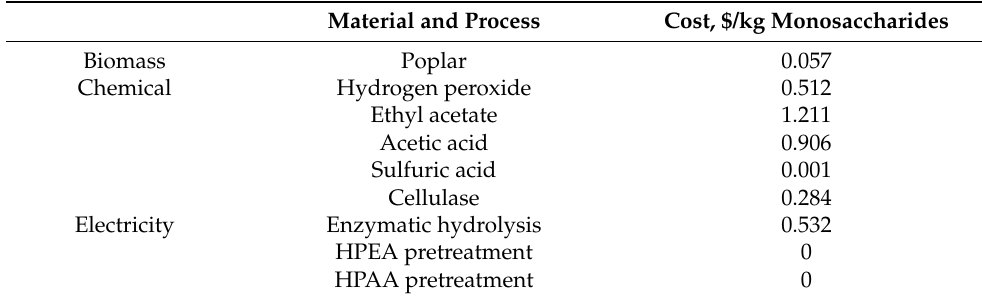
Table 5. HPEA pretreatment poplar monosaccharide production cost estimation. Material and Process Cost, $/kg Monosaccharides Biomass Poplar 0.057 Hydrogen peroxide